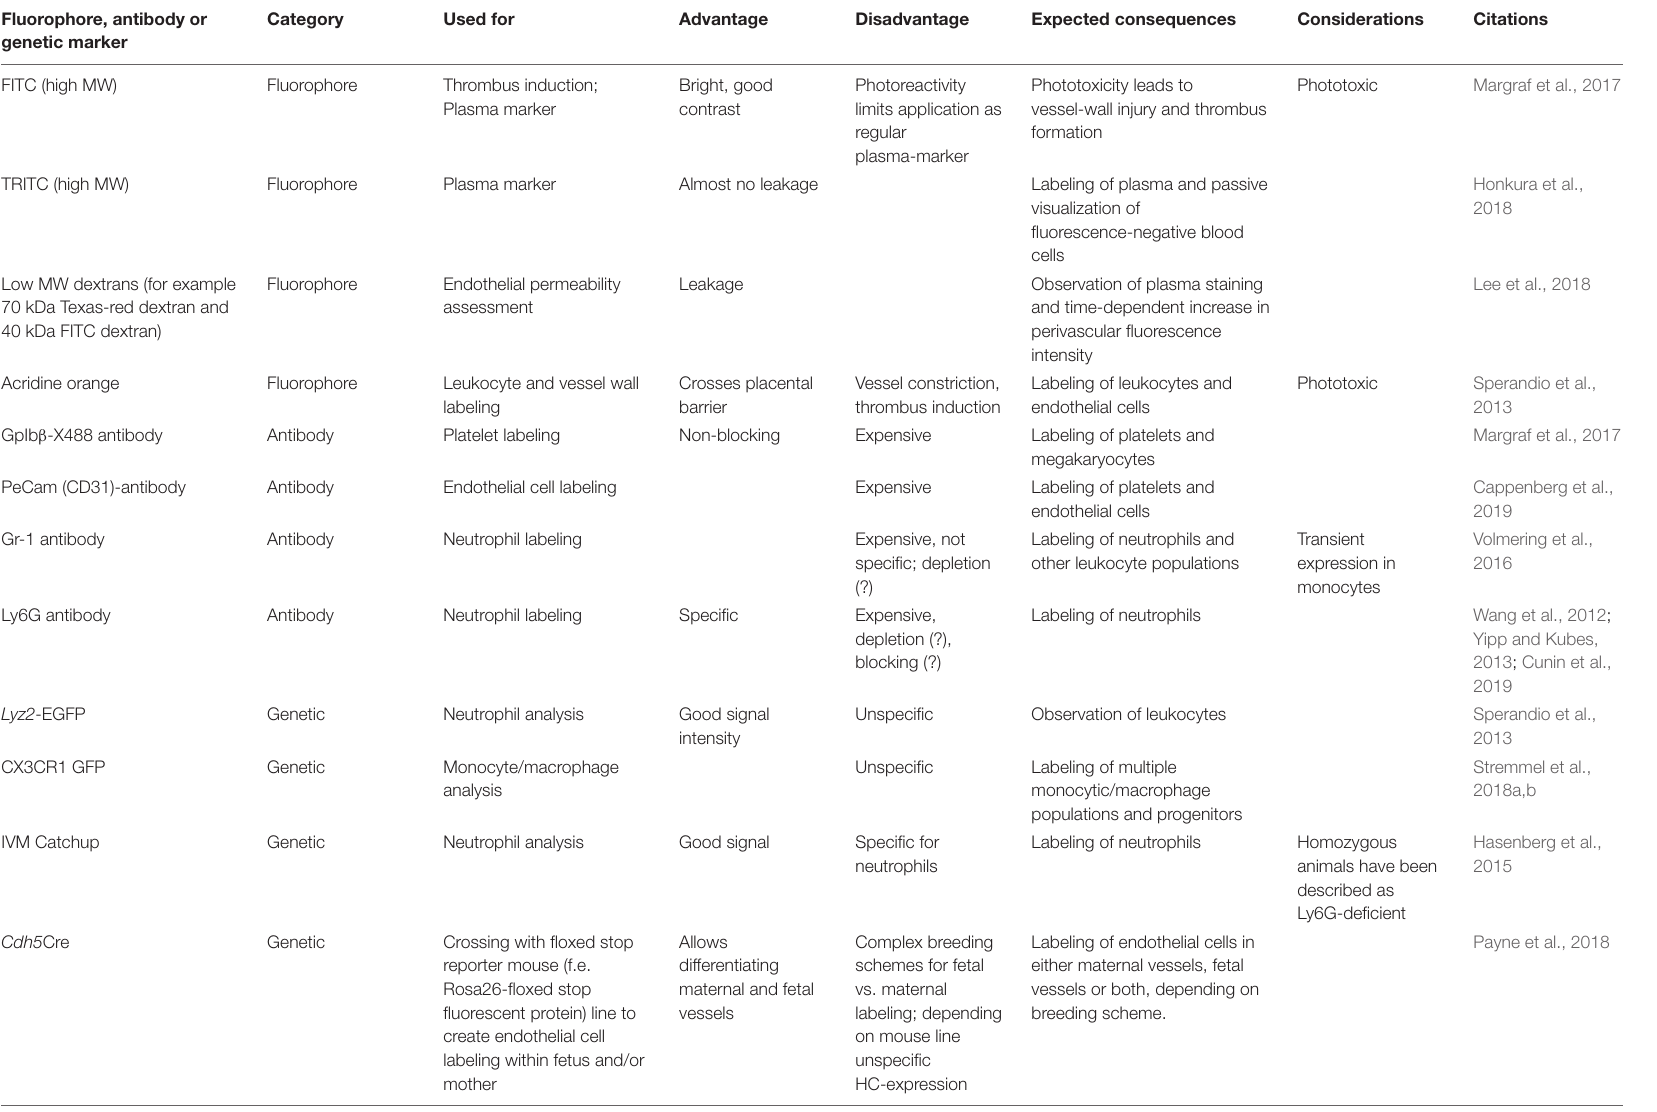
TABLE 1 | Antibodies, fluorophores, and markers used for in vivo imaging in the mouse fetus. Fluorophore, antibody or genetic